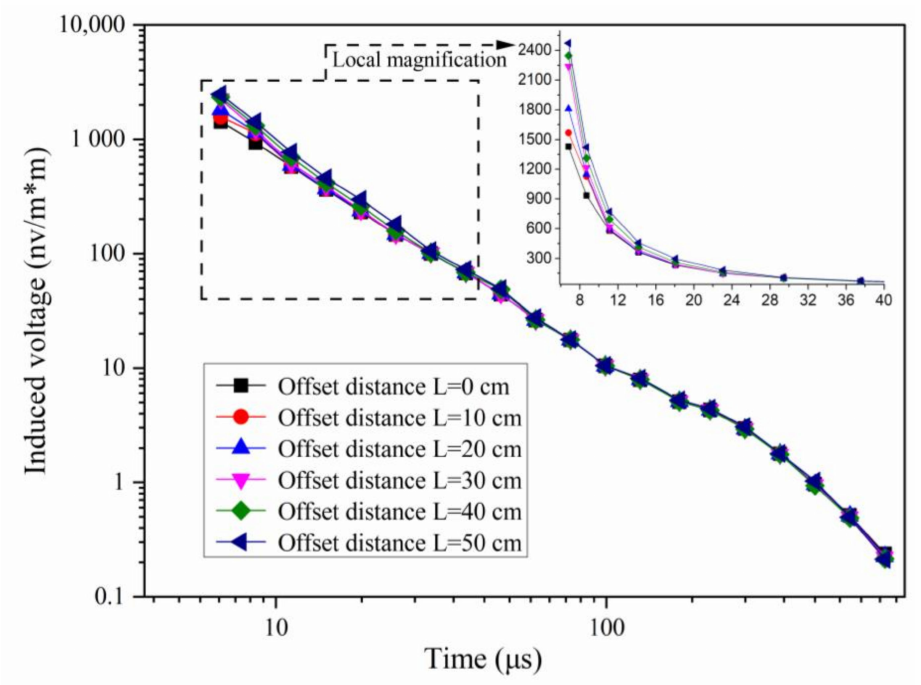
Figure 16. Response curve of the saline model under different coil offset